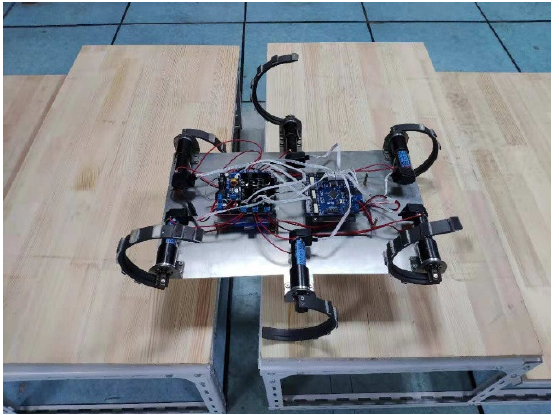
Figure 13. Experiment of robot crossing gullies. Table 4. Experimental results of robot jumping task. Gully Width (cm)